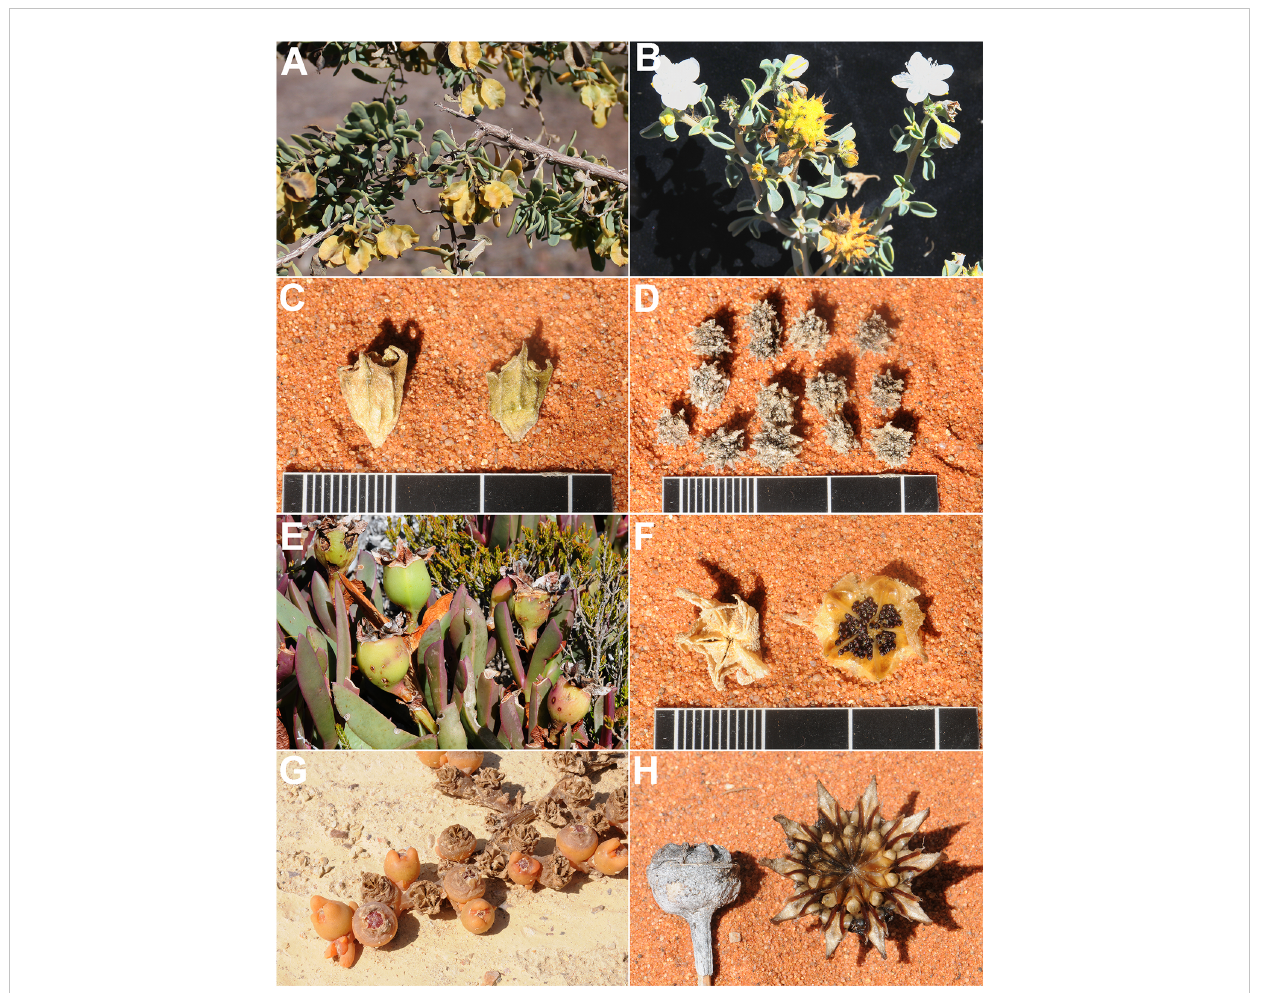
FIGURE 1 Xerochastic (A-E) and hygrochastic (F-H) fruits of selected Aizoaceae species. (A) Anisostigma schenckii , (B) Tribulocarpus dimorphanthus , (C) Tetragonia tetragonoides , (D) Tetragonia echinata , (E) Carpobrotus acinaciformis , (F) Top view of closed (l) and open (r) fruit, Aizoanthemopsis hispanica , (G) Mesembryanthemum cryptanthum , and (H) Side view of closed (l) and open (r) fruit, Cheiridopsis alba-oculata